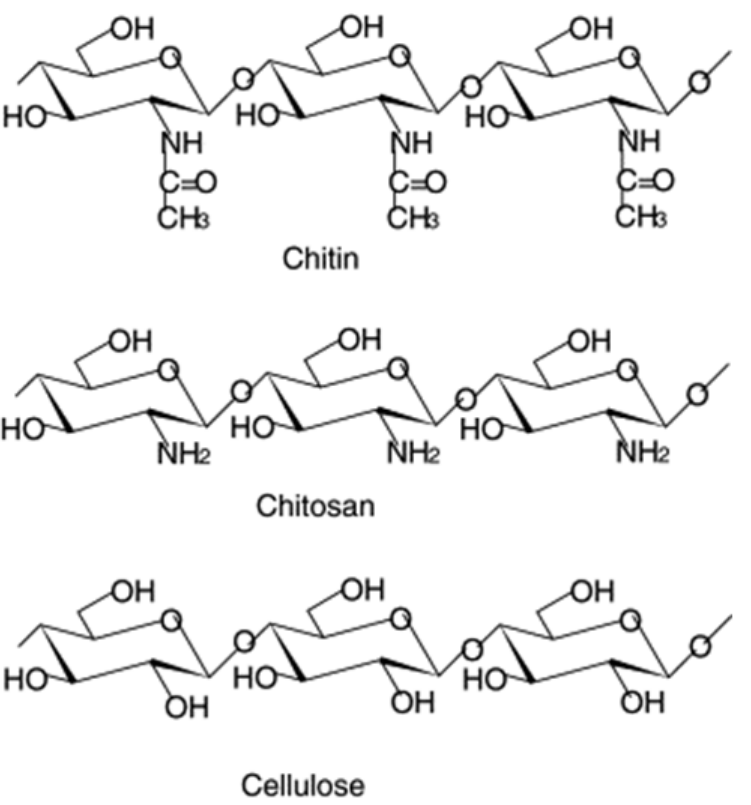
Figure 1. Structures of chitin, chitosan, and cellulose. Reprinted from [33] with permission from Elsevier.